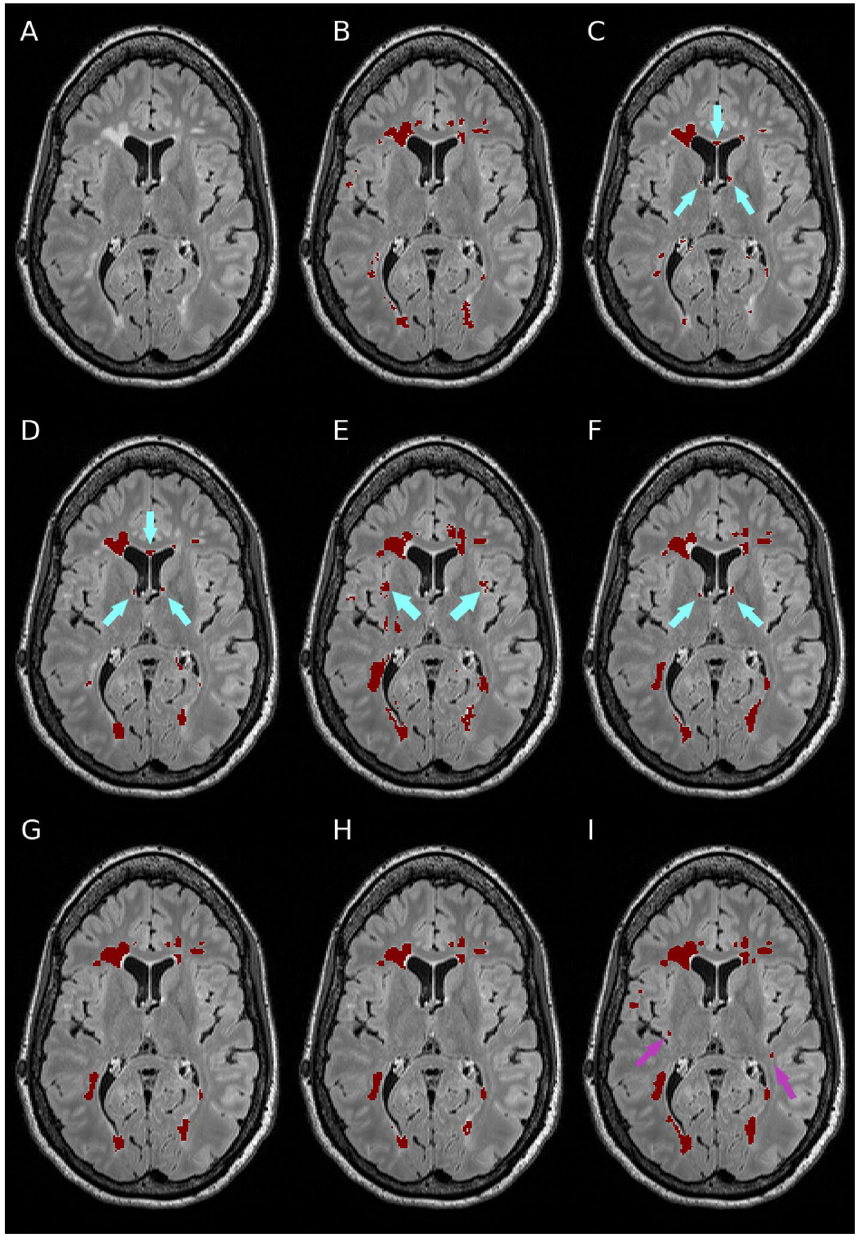
Figure 2. Example segmentations of a case from the Insel32 dataset, axial view. ( A ) FLAIR image, plus segmentations from ( B ) manual raters, ( C ) LPA, ( D ) LGA, ( E ) nicMSlesions and ( F ) nnUnet (all labels) ( G ) DeepSCAN (just lesions) ( H ) nnUnet (just lesions) ( I ) DeepSCAN (all labels). Segmentations from LGA, LPA, and nnUnet (all labels) show erroneous segmentation of healthy-appearing tissue near the ventricles (cyan arrows). nicMSlesions labels healthy cortical grey matter as lesion tissue (cyan arrows) DeepSCAN (all labels) identified two subtle lesions (violet arrows) missed by the manual raters but subsequently confirmed by our experienced